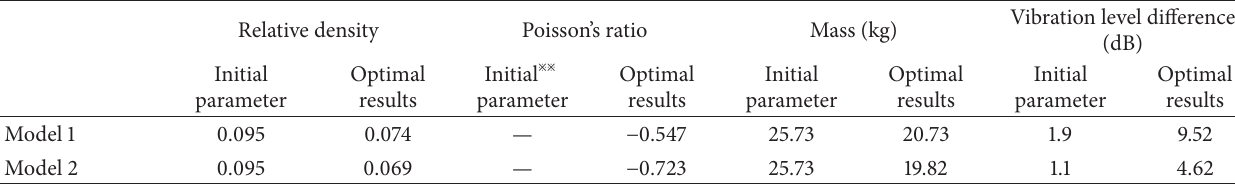
Table 3: Comparison of different optimal models n .